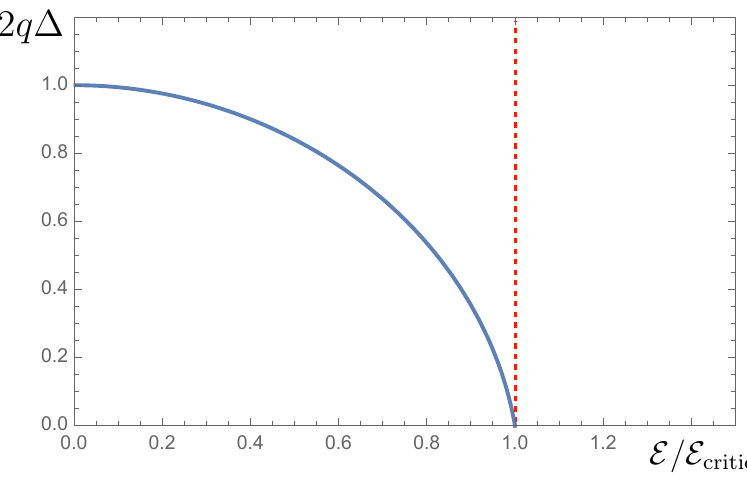
Figure 2 . Plot showing the conformal solution for the fermion scaling dimension ∆ as a function of the spectral asymmetry E for q = 3 . The behavior is similar for other values of q . We see the scaling dimension reaches zero at the critical spectral asymmetry, and for larger E , the conformal ansatz is invalid, to the right of the dashed red